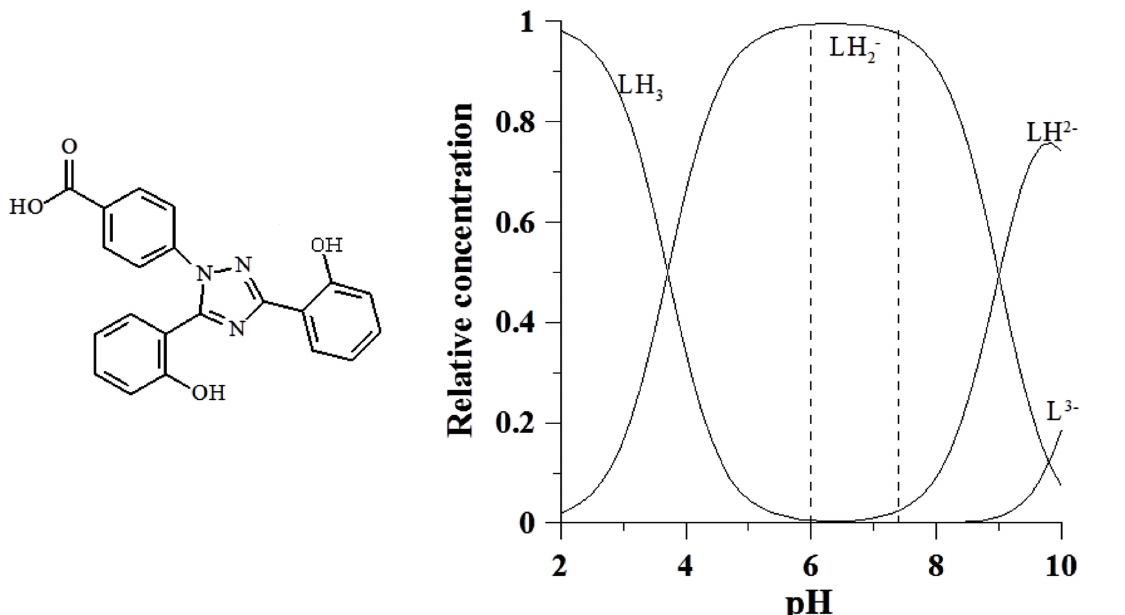
Fig 3. Molecular formula of exjade and speciation plots of its variously protonated